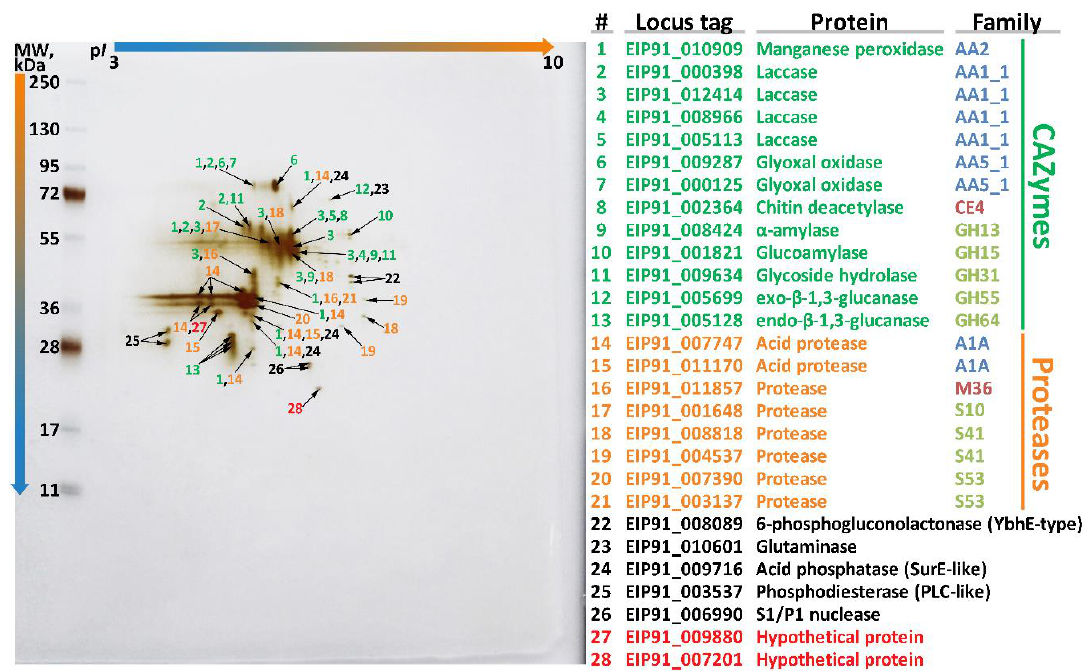
Figure 5. Two-dimensional gel electrophoresis (2DE) of the exoproteome of S. ochraceum cultivated on the lignocellulose substrate.